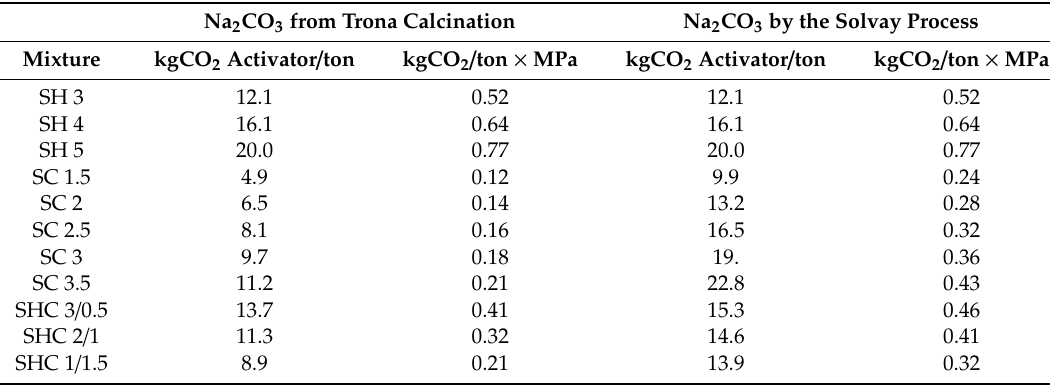
Table 7. Kilograms CO 2 emissions from the activator for each mortar per ton of prepared mortar, and per ton of mortar and megapascal, for Na 2 CO 3 from trona calcination and by the Solvay